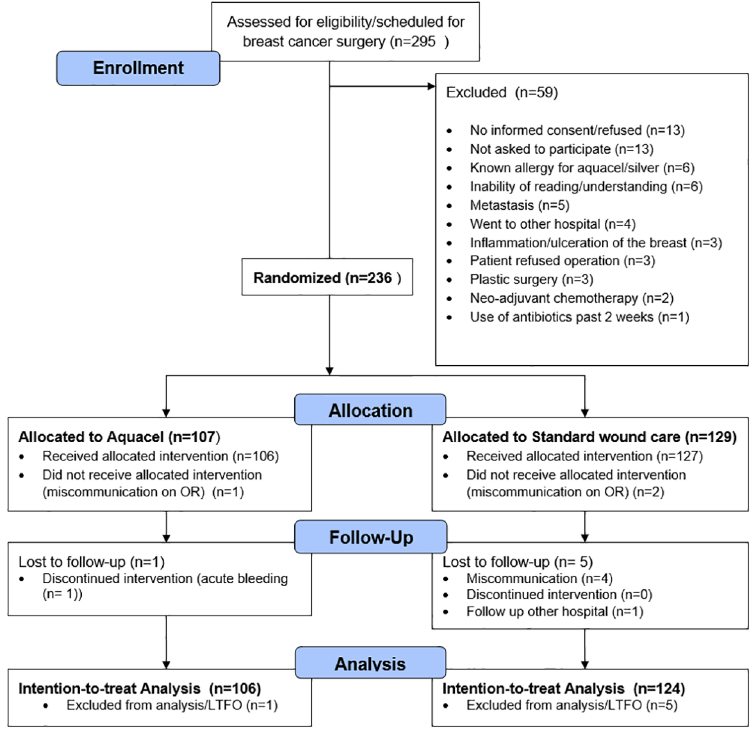
Fig 1. CDC criteria for an SSI [14,22]. a Diagnosis of ‘cellulitis’ alone does not meet criterion 4 since 2010, but this change underestimates the infection rate and is not recommended to be used by Degnim [5].